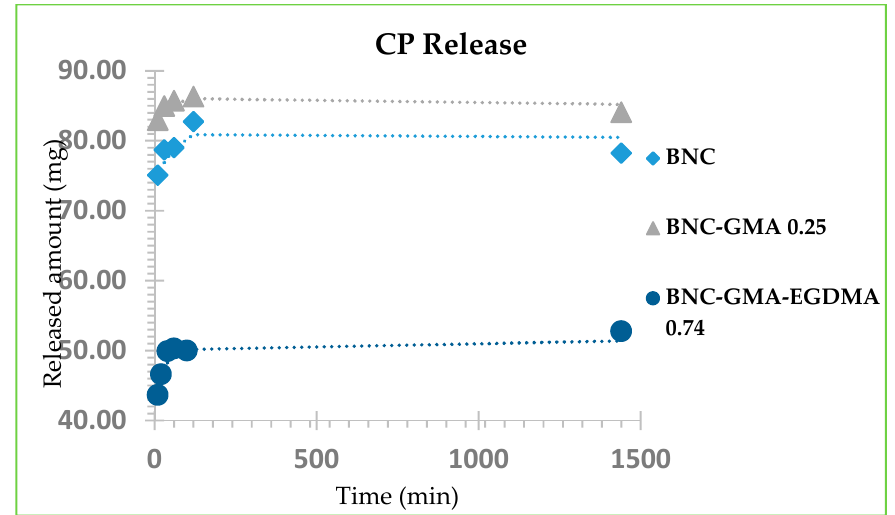
Figure 19. Kinetic of ciprofloxacin (CP) release from BNC (light blue); BNC-GMA MS = 0.25 (grey); BNC-EGDMA MS = 0.74 (blue).